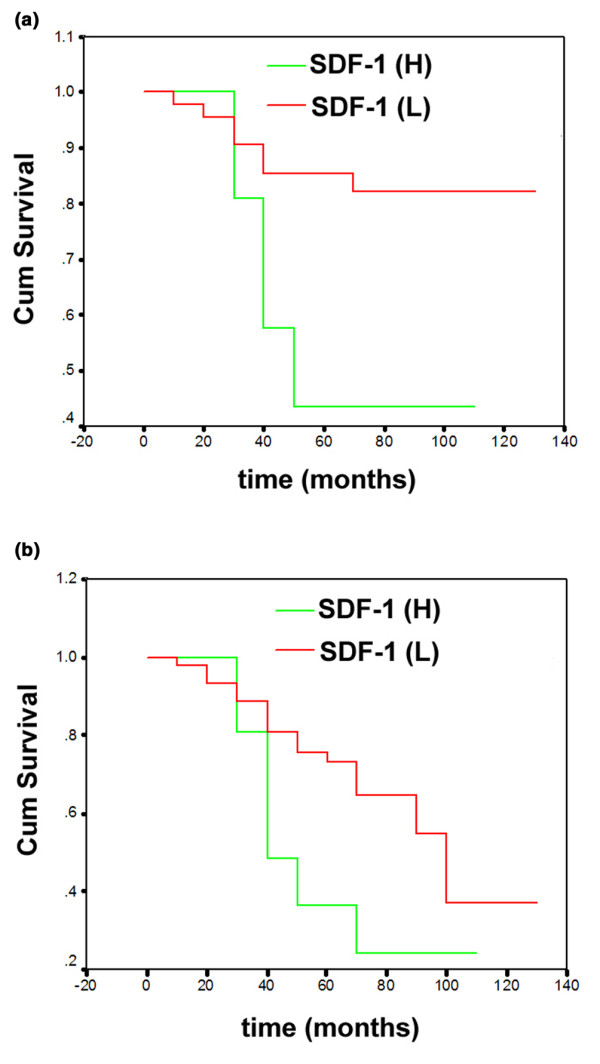
Kaplan–Meier survival curves. (a) Overall survival (P = 0.01). (b) Disease-free survival (P = 0.035). Median follow up: 72.2 months. Stromal cell-derived factor (SDF)-1 (H), patients with high levels of SDF-1 transcript (n = 79); SDF-1 (L), patients with low levels of SDF-1 transcript (n = 41).